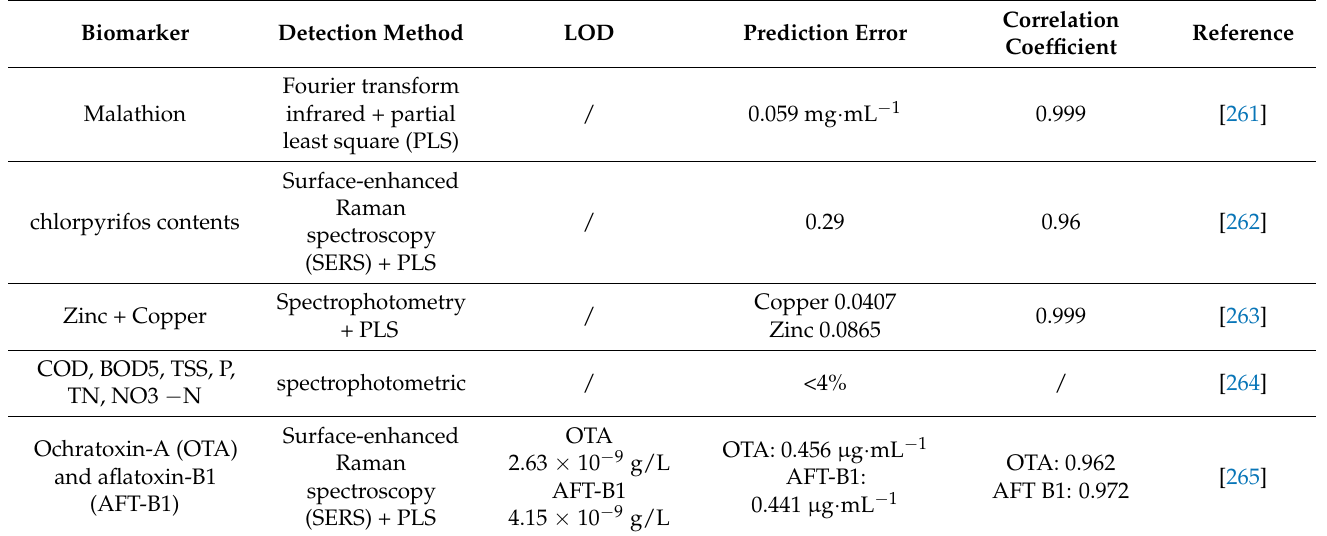
Table 2. Summary of genetic algorithm (GA) applied to pollutants